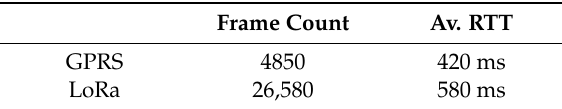
Table 3. FITRA Communication Protocol Performance results over GPRS and LoRa OWS